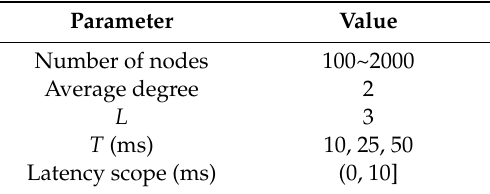
Table 2. Evaluation setting.